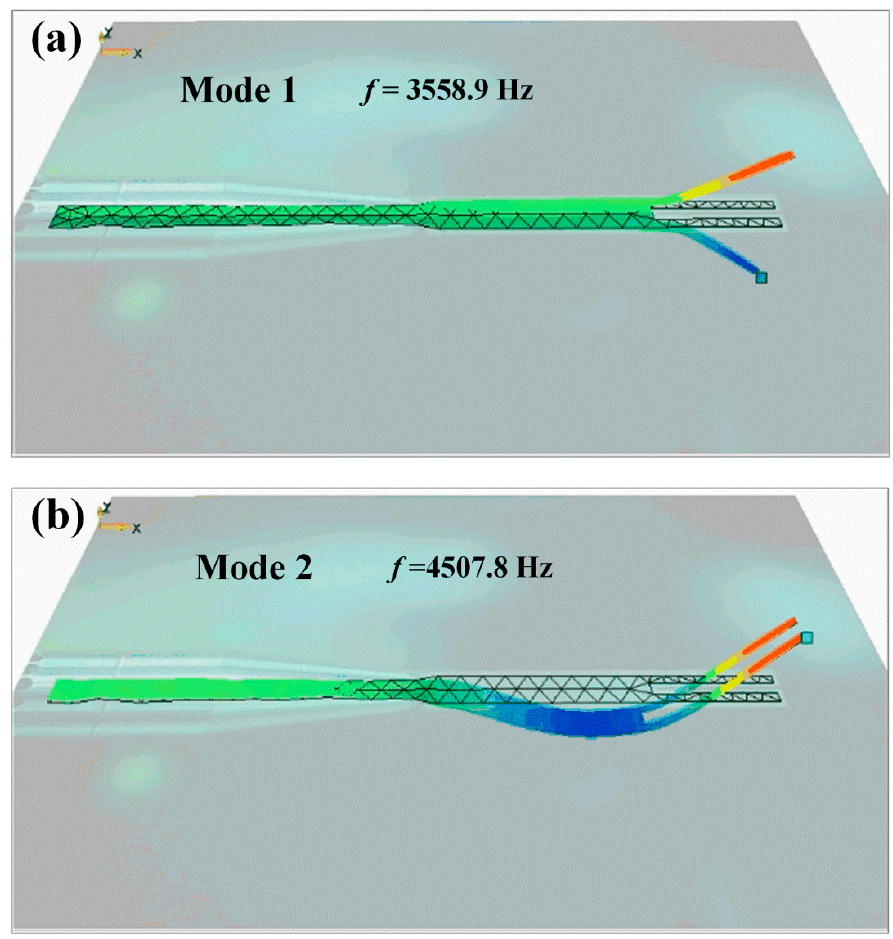
Figure 10. Scanning mode shapes around the resonant frequency: (a) scissoring mode and (b) normal bending mode.